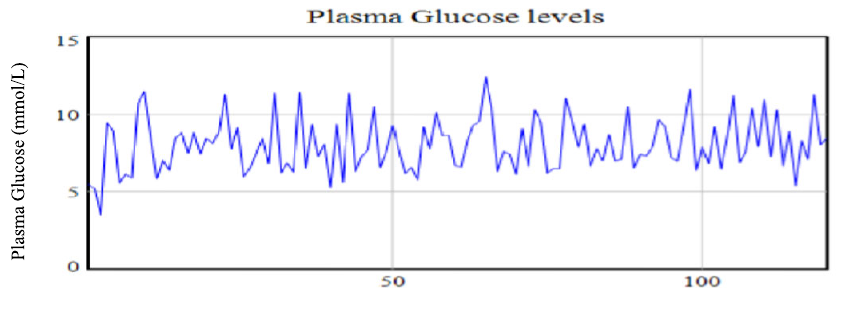
Figure 11. Plasma glucose levels using identified parameters for the extended Bergman Minimal Model for a type II diabetic patient with reduction of 33.33% in both the amount of carbohydrates taken and stress levels while holding physical exercise intensity at the base run level.